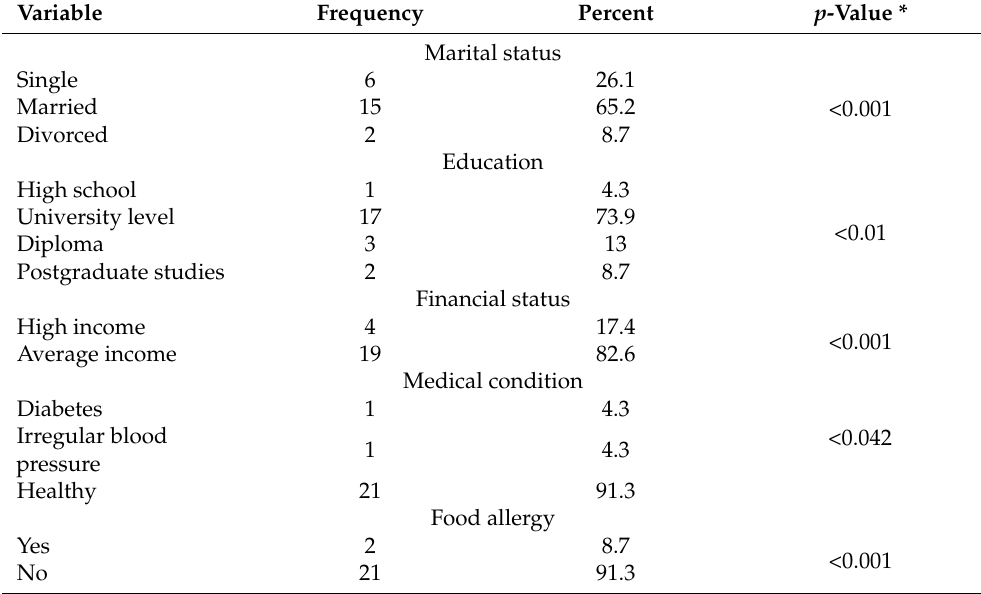
Table 1. Frequency distribution of participants ( n = 23) according to demographic